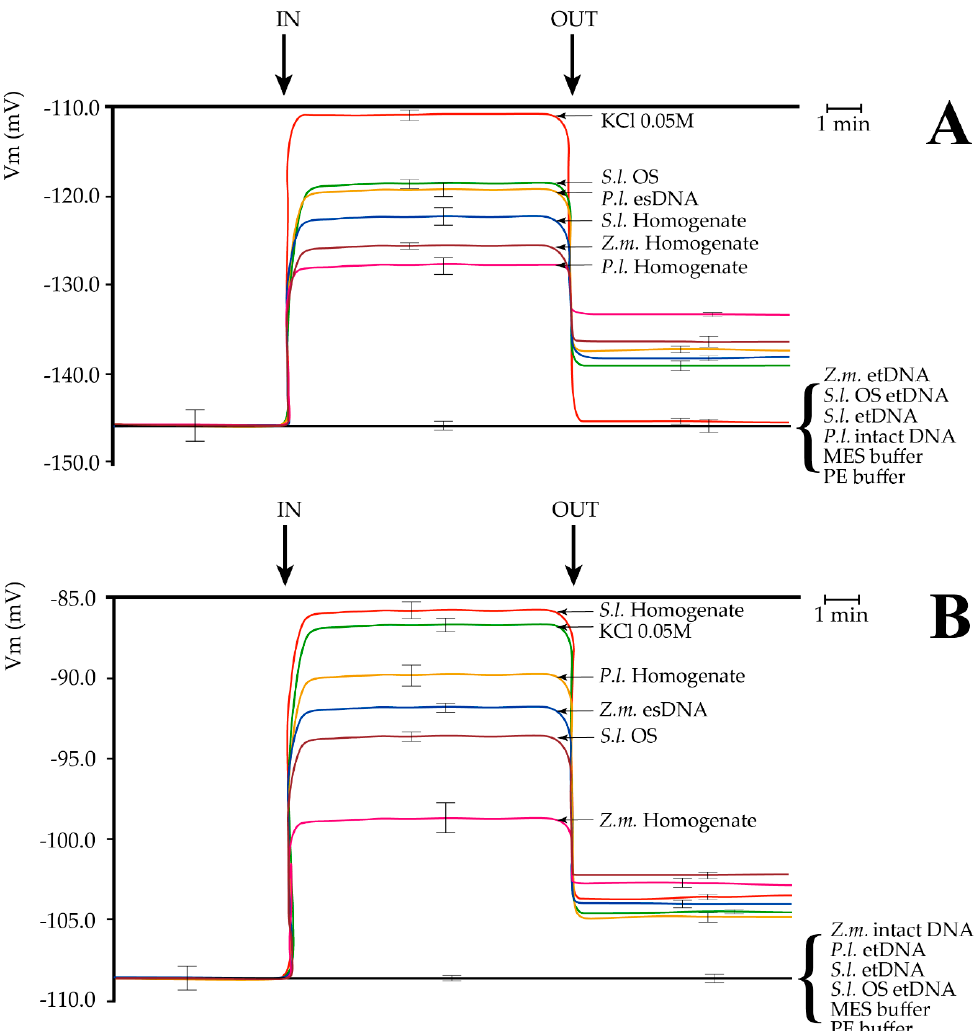
Figure 3. Plasma membrane potential (Vm) depolarization caused by different treatments in Lima bean ( Phaseolus lunatus ) and maize ( Zea mays ) leaves. ( A ) Perfusion of Lima bean leaves with lima bean esDNA caused a Vm depolarization similar to S. littoralis oral secretions (OS). Leaf and larval homogenates were also found to induce a significant Vm depolarization. No effect on Vm was found after buffers, P.l. intact DNA, or extracellular heterologous DNA (etDNA) application; ( B ) Perfusion of maize leaves with maize esDNA caused a Vm depolarization similar to S. littoralis OS. Leaf and larval homogenates were also found to induce a significant Vm depolarization. No effect on Vm was found after buffers, Z.m. intact DNA or etDNA application. P.l. , Phaseolus lunatus ; Z.m ., Zea mays ; S.l ., Spodoptera littoralis ; OS, oral secretions. IN, time of perfusion of different solutions; OUT, time of washing with fresh buffer. A time scale is indicated. Error bars represent standard error ( n = 8–10).